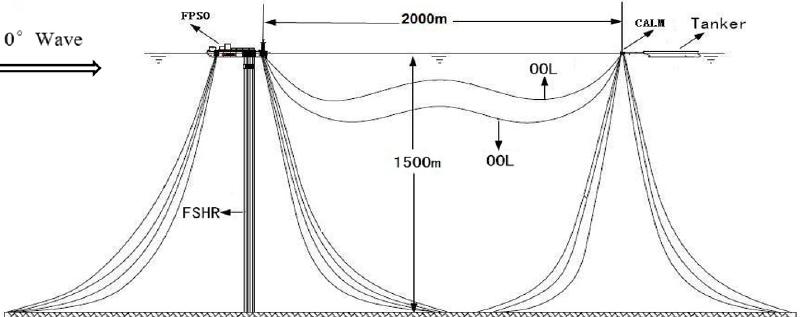
Figure 1. Schematic diagram of the numerical model of the FPSO CALM buoy offloading system.